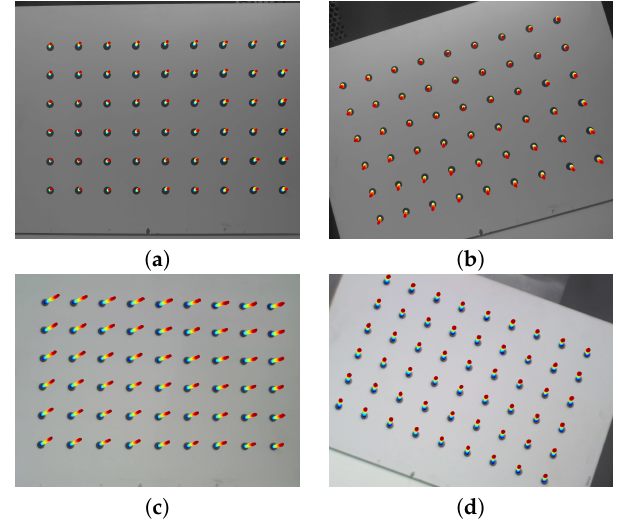
Figure 5. The image drift observed for normal ( a , c ) and rotated ( b , d ) camera positions. The background image is the first captured frame. Colored dots (blue for reference temperature—the coolest) represent the next locations of calculated marker centers. Each next coordinate was multiplied × 100 times for better visualization. Figures ( a , b ) present image drift for the IDS camera; ( c , d ) are the image drift for the Basler